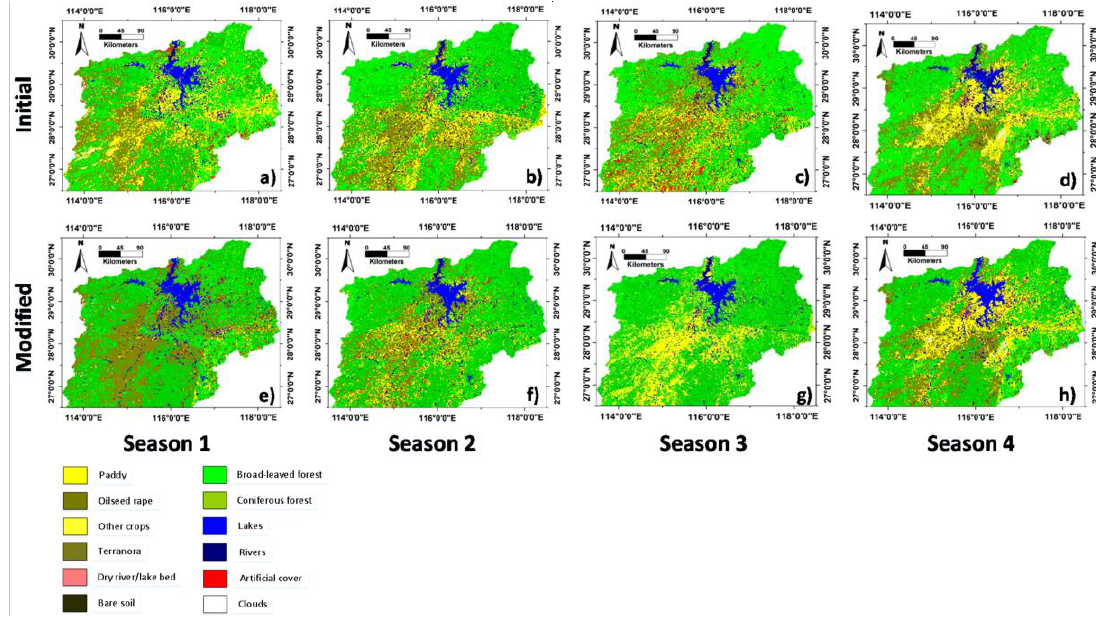
Figure 5. Land cover maps of Poyang Lake Basin for different seasons. ( a – d ) present the results produced by the initial strategy; ( e – h ) present the results after the modification procedure.